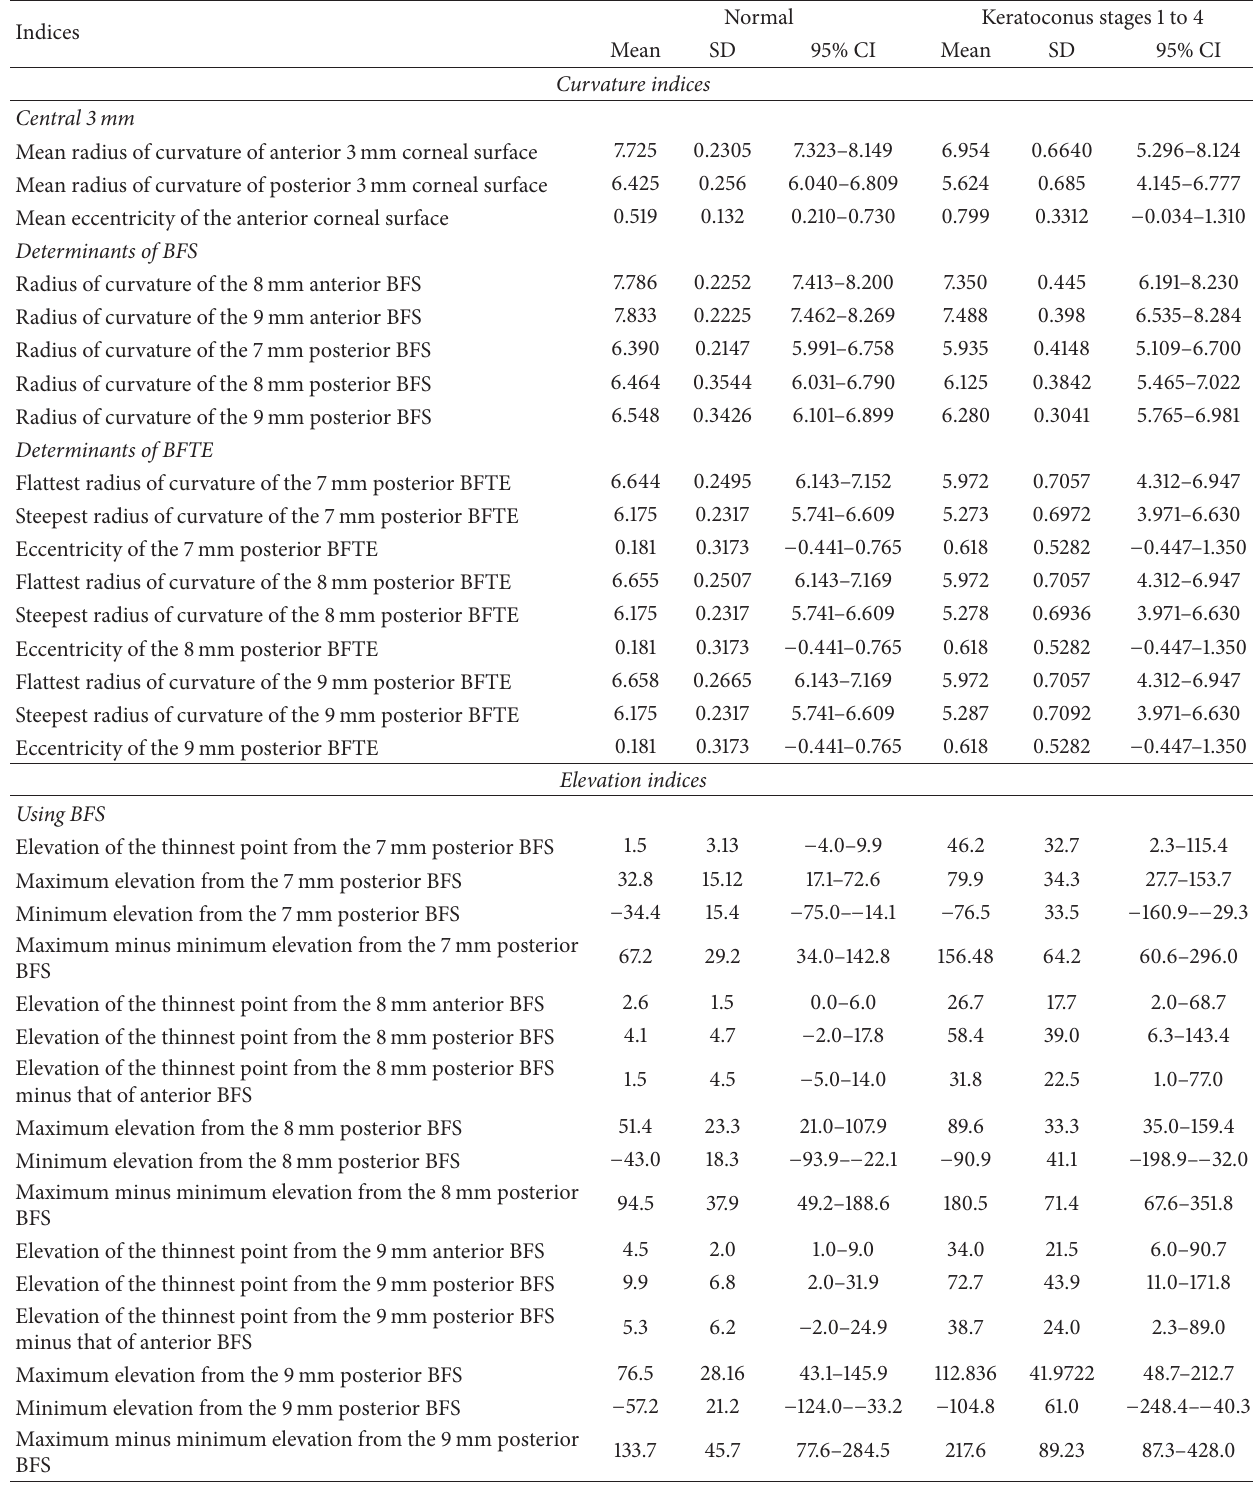
Table 1: The mean, SD, and 95% confidence interval (CI) of all tested KC detecting parameters. Radii of curvature are in mm, elevations in 𝜇 m, pachymetry in 𝜇 m, and decentration in